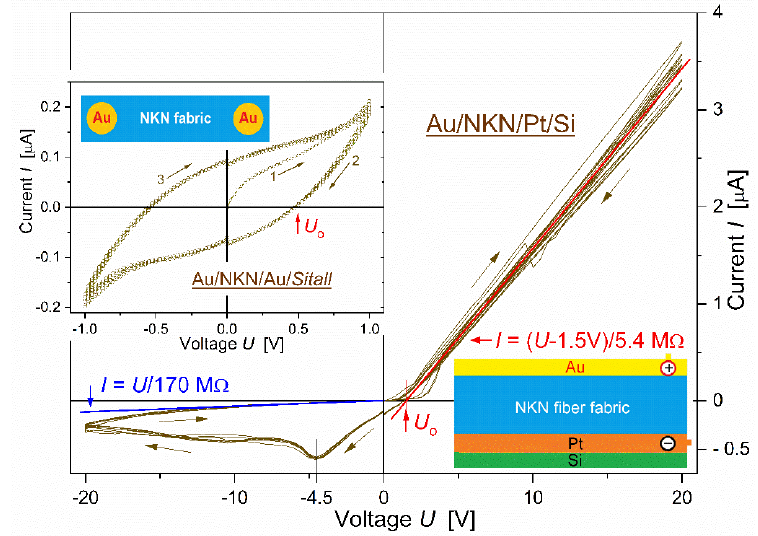
Figure 6. Current – voltage I – V characteristics traced with Keithley 2410 SourceMeter. Main frame – in Figure 6. Current–voltage I–V characteristics traced with Keithley 2410 SourceMeter. Main frame–in the vertical Au/NKN(260 μm)/Pt/Si diode cell. Red straight line I = ( U − 1.5 V)/5.4 MΩ is the average the vertical Au/NKN(260 µ m)/Pt/Si diode cell. Red straight line I = ( U − 1.5 V)/5.4 M Ω is the of multiple cycle I – V traces in the forward direction. Blue straight line I = U /170 MΩ fits the upward average of multiple cycle I–V traces in the forward direction. Blue straight line I = U /170 M Ω fits reversal I – V branch in the log – log scale (not shown). Left upper inset – enlarged part at low voltages the upward reversal I–V branch in the log–log scale (not shown). Left upper inset–enlarged part at in the planar Au/NKN(350 μm)/Au/ Sitall cell onto dielectric substrate. In planar and vertical cells, low voltages in the planar Au/NKN(350 µ m)/Au/ Sitall cell onto dielectric substrate. In planar and remnant ferroelectric polarization nullifies the current in downward I – V branches at positive volt- vertical cells, remnant ferroelectric polarization nullifies the current in downward I–V branches at age U o = 0.5 and 1.5 V, correspondingly. positive voltage U o = 0.5 and 1.5 V,